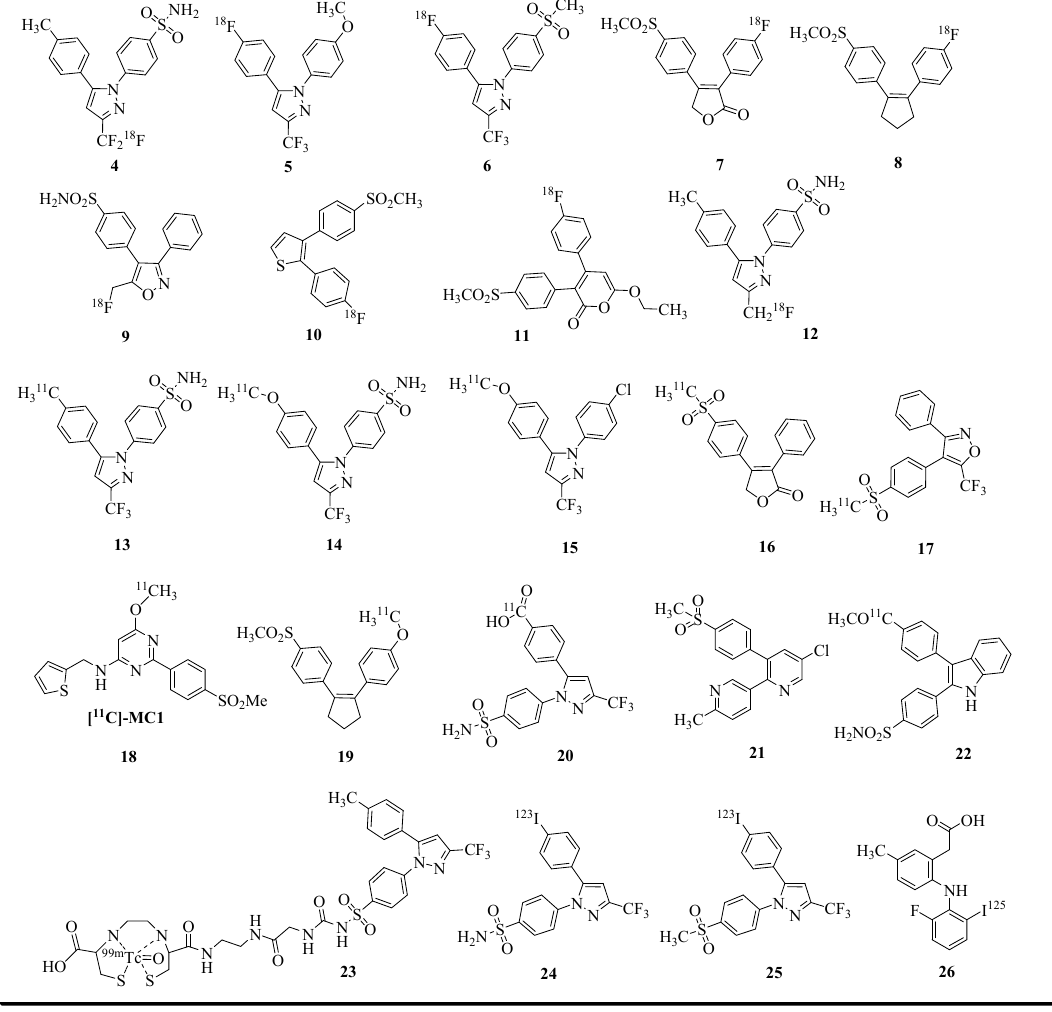
Figure 3. Selected examples of radioligands for COX-2 imaging.